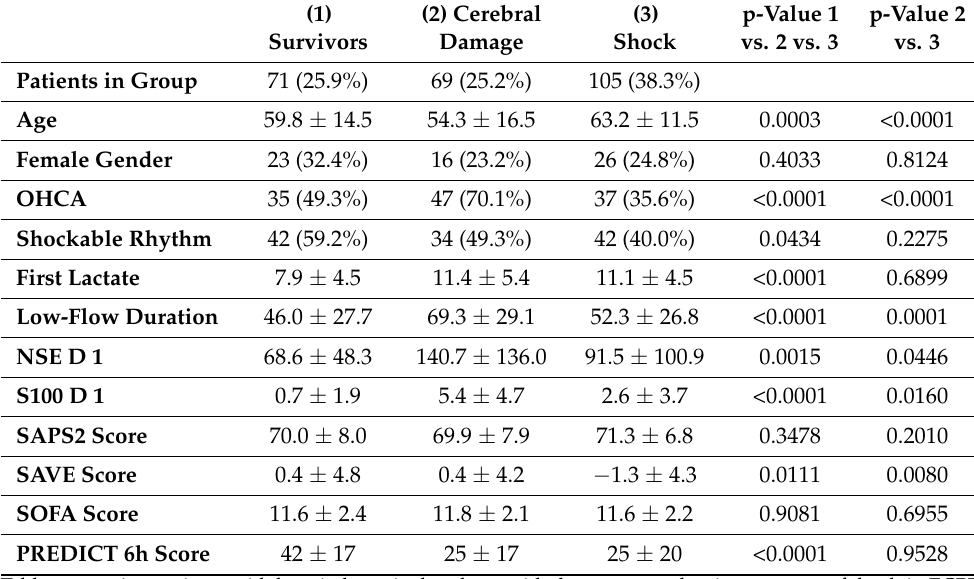
Table comparing patients with hospital survival to those with the two most dominant causes of death in ECPR